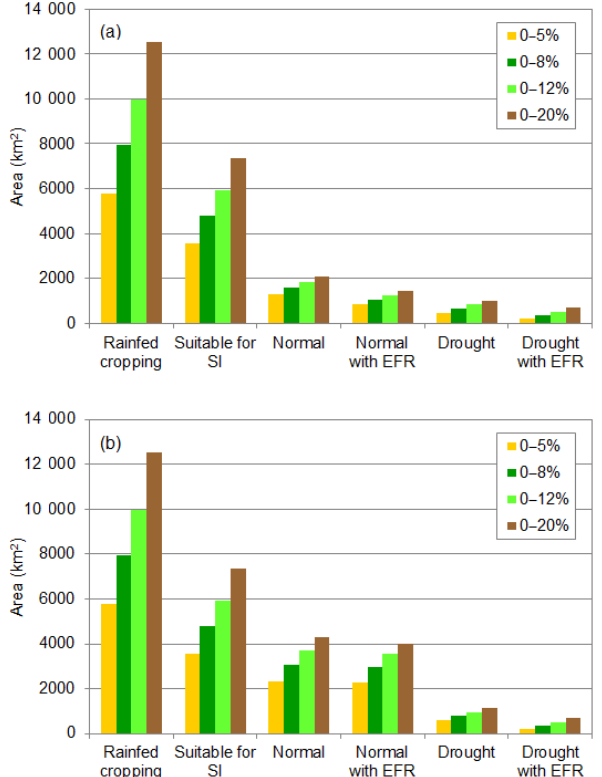
Figure 2. Rainfed crop areas for four different slope classes for the whole upper Karkheh River basin; rainfed crop areas suitable for supplemental irrigation (SI) (within 1km buffer from the streams); and suitable areas that receive supplemental irrigation under the four flow scenarios (normal flow, normal with environmental flow requirements (EFRs), drought conditions, and drought with EFRs); areas that receive both autumn and spring irrigation (a) ; areas that receive either autumn or spring irrigation or both (b)